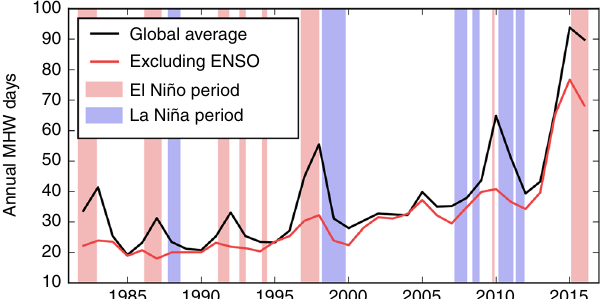
Fig. 2 Total number of marine heatwave days globally. Globally averaged time series of total marine heatwave (MHW) days from NOAA OI SST over 1982 – 2016. The black line shows the globally averaged time series of total MHW days from NOAA OI SST over 1982 – 2016. The red line shows this metric after removing the signature of ENSO. The light red and blue shading indicate El Niño and La Niña periods, respectively, de fi ned by periods exceeding ±1 s.d. of the MEI index for three consecutive months